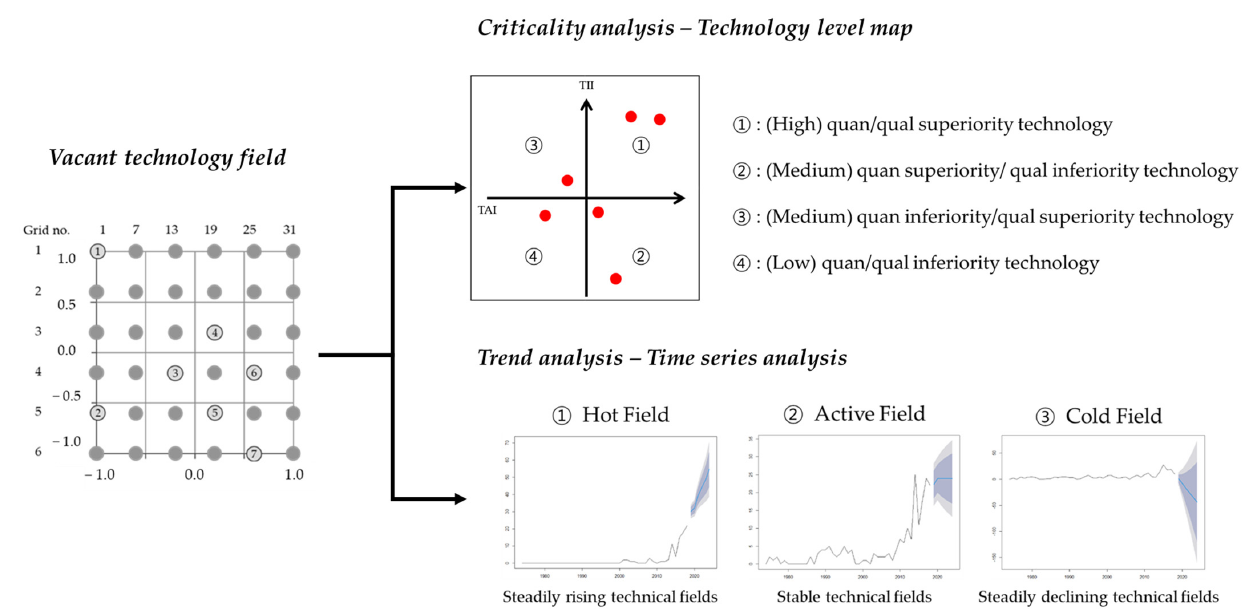
Figure 3. Technical analysis of a vacant technology field.